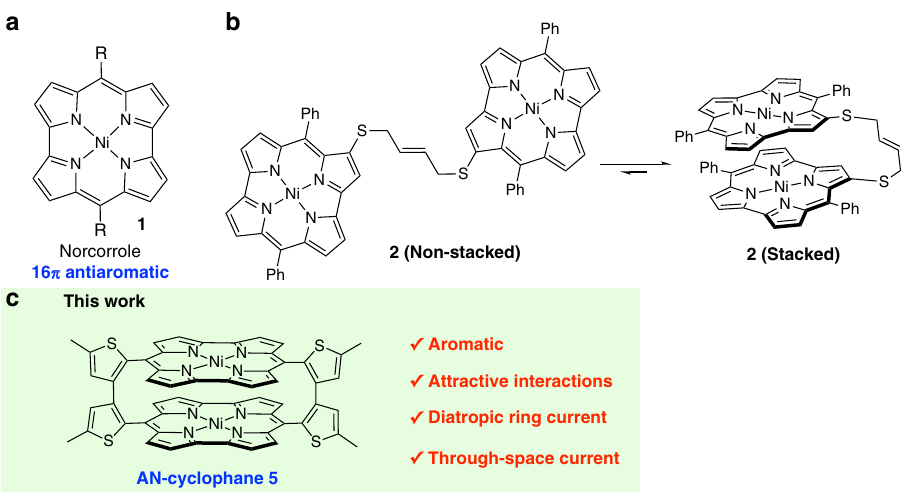
Fig. 2 Norcorroles and a norcorrole cyclophane. a Chemical structures of norcorrole Ni(II) complex 1 . b Tethered norcorrole Ni(II) dimer 2 and its dynamic equilibrium. c AN-cyclophane 5 which contains two stacked norcorrole Ni(II) units